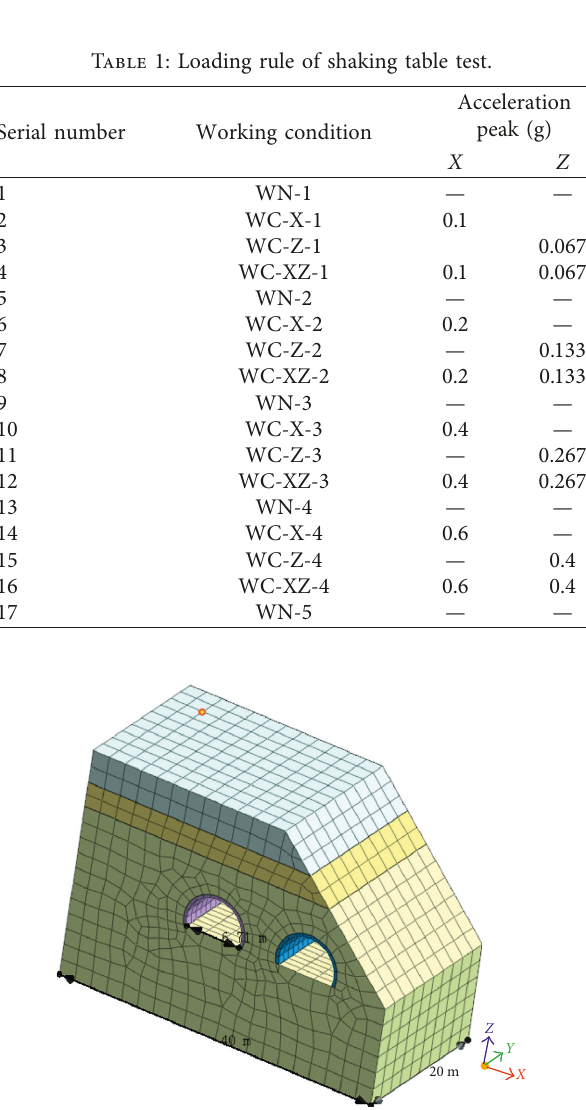
Figure 5: Numerical